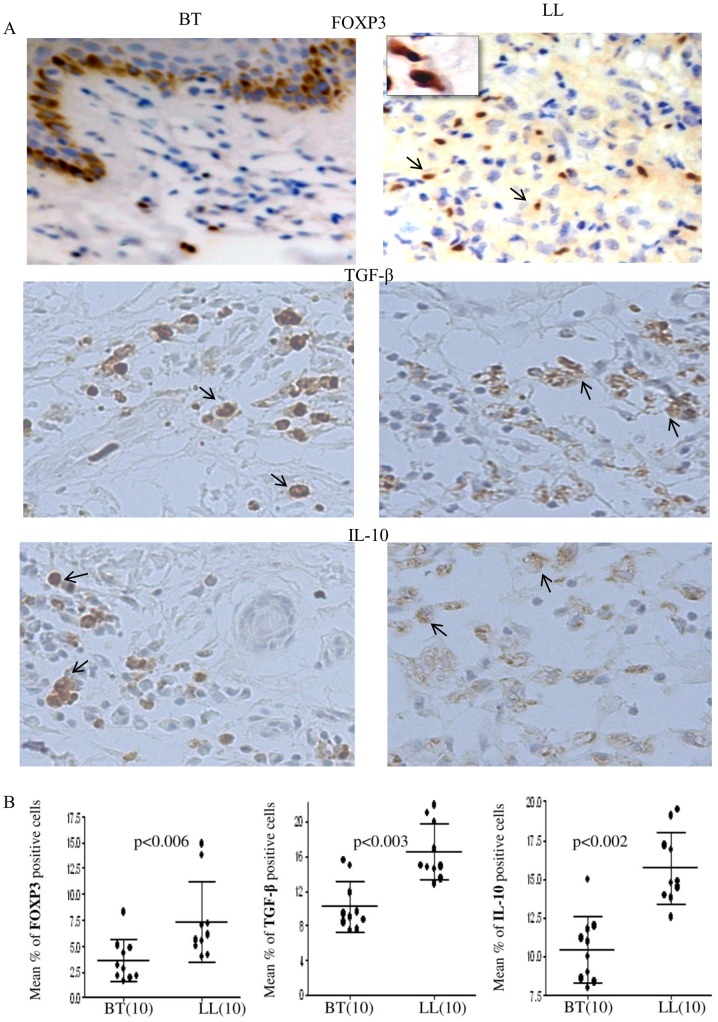
Increase in FOXP3+, TGF-β+ and IL-10+ cells in lepromatous leprosy skin lesions.Immunohistochemistry on representative skin lesions from borderline tuberculoid (BT) and lepromatous leprosy (LL) patients. A. FOXP3 with inset showing detail of nuclear staining, cytoplasmic TGF-β and IL-10 respectively. Diaminobenzidine was used as chromogen after treatment with appropriate anti-human antibodies as given in Materials and Methods. Original magnification: 200× inset 400× B. Scatter diagram showing increase of cells with FOXP3+ TGF-β+ and IL-10+ in lepromatous leprosy (LL) as compared to tuberculoid leprosy (BT) lesions. Horizontal and vertical bars indicate Mean%±SD of positive cells of 1000 total cells. p<0.05 was considered significant by two tail Mann Whitney test. Figures in parenthesis indicate the number of subjects.